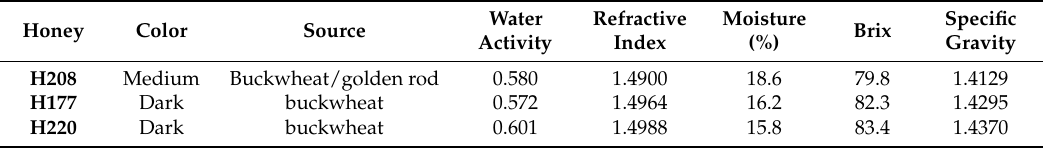
Table 3. Some physical–chemical properties of tested